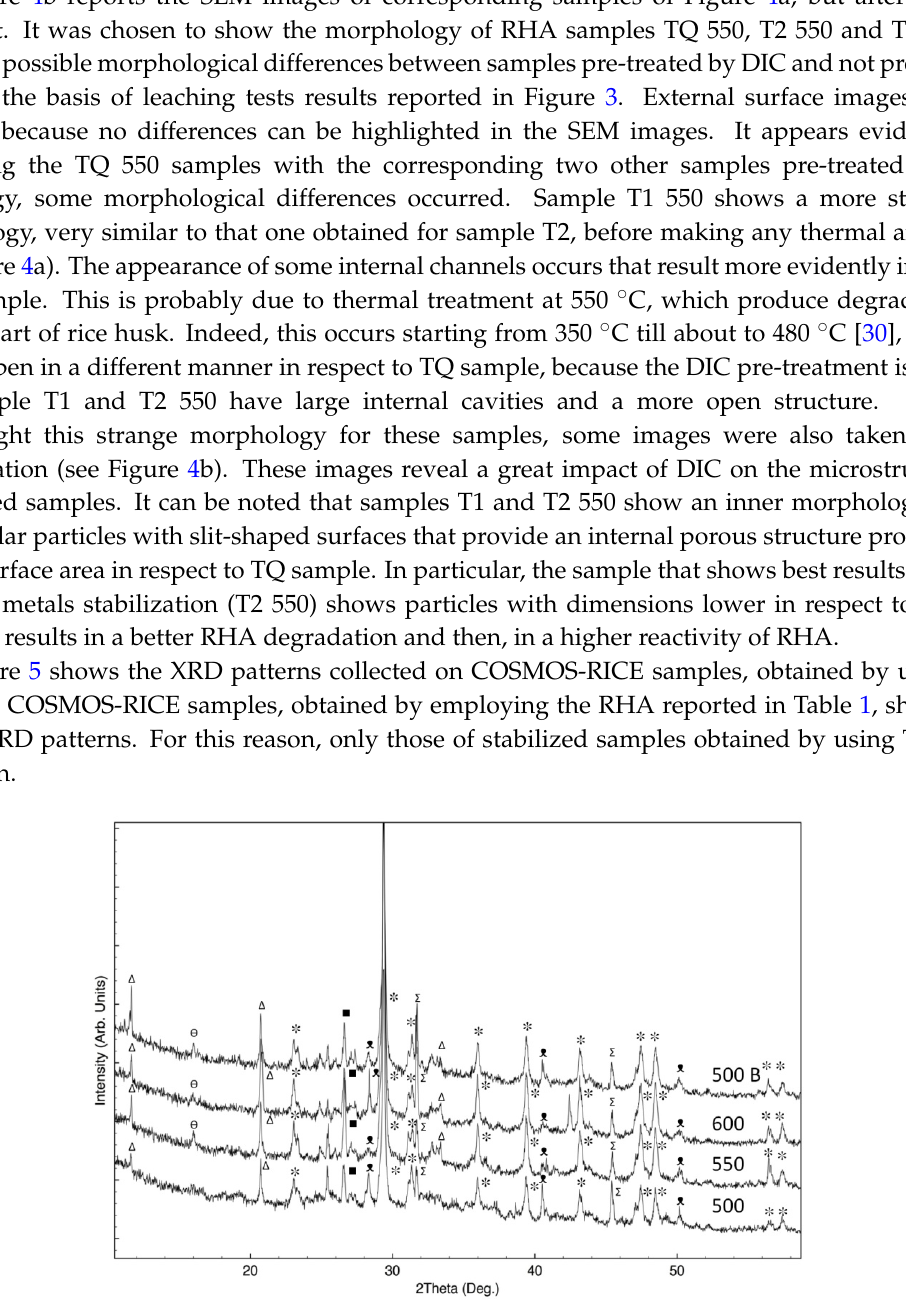
Figure 5. XRD patterns collected on COSMOS ‐ RICE samples, obtained by using TQ RHA (see Table 1). ✻ : ˚ : Calcite (CaCO 3 ); Σ : Halite (NaCl); ∆ : Gypsum [CaSO 4 ¨ 2(H 2 O)]; θ : Thaumasite